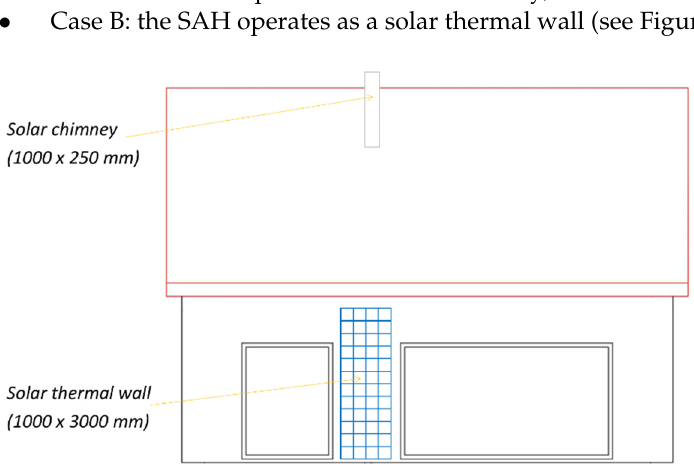
Figure 11. The solar façade of the analyzed building including the SAH in the form of a solar chimney and solar thermal wall. Table 9. The estimation of the average monthly efficiency of the SAH in the form of a solar chimney and thermal storage wall.